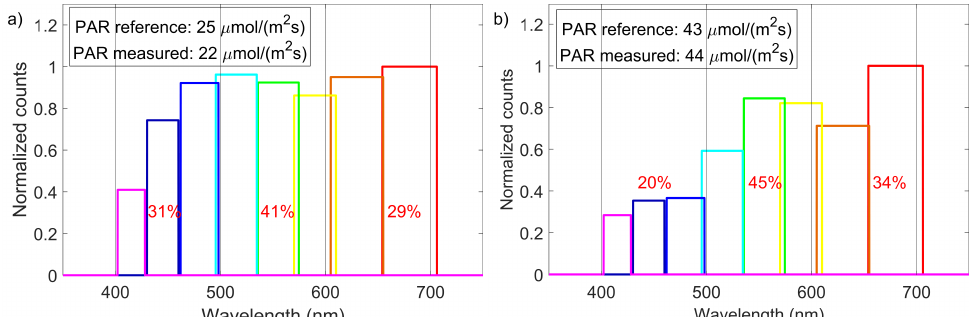
Figure 7. Measurement of direct sunlight on a clear summer day ( a ) and under a leaf ( b ). The mea- sured PARs with both sensors are noted in the graph. The spectral channels are normalized to the highest count number of all channels. The RLQI values do not sum up to 100% because of rounding